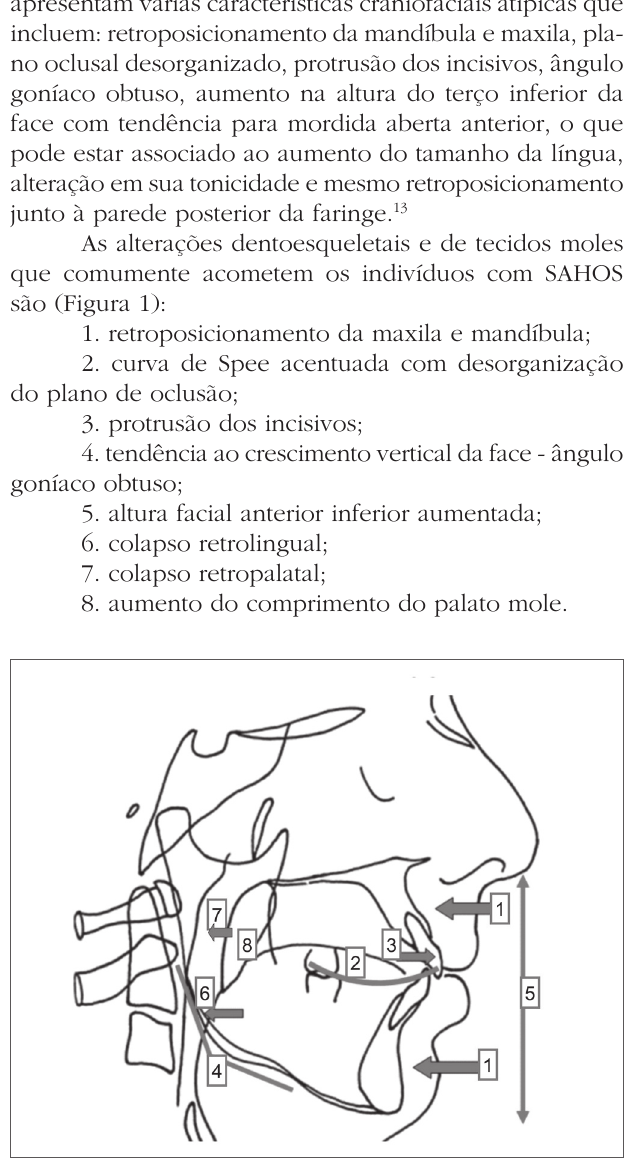
Figura 1. Cefalograma identificando as características faciais típicas dos indivíduos com